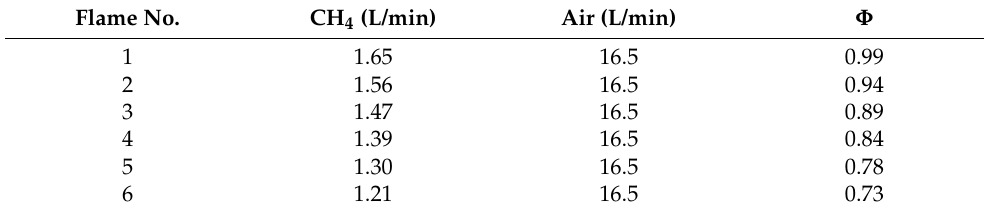
Table 1. Experimental conditions of the premixed CH 4 /air flame in this work. Flame No. CH 4